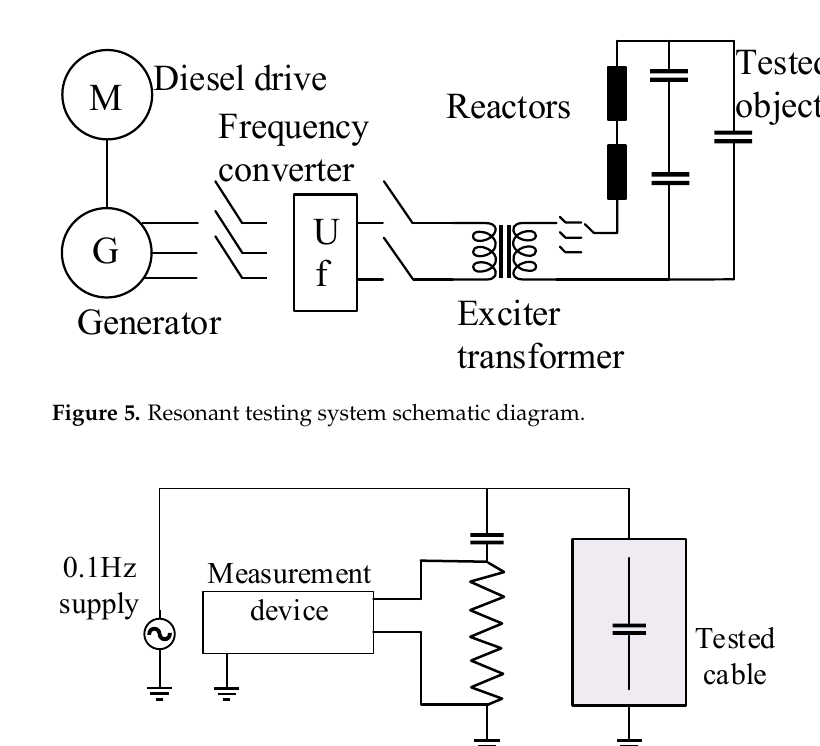
Figure 6. VLF testing system schematic diagram.